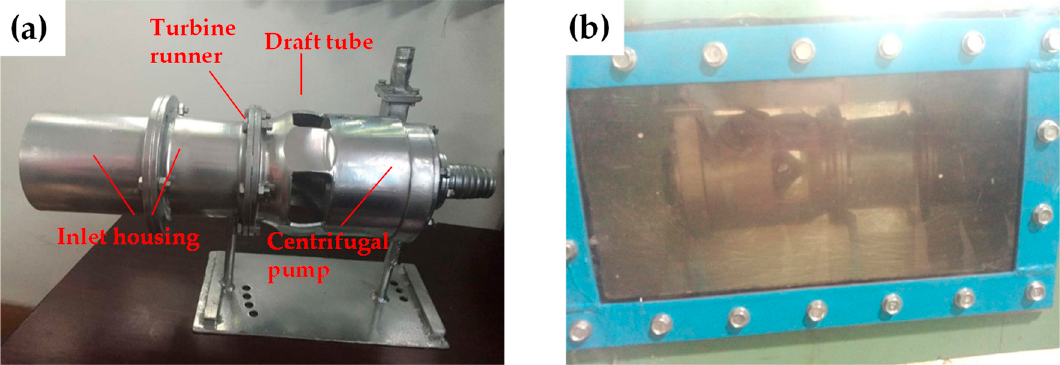
Figure 2. Photos of WTP unit: ( a ) physical model of the WTP and ( b ) photo of the unit installation.